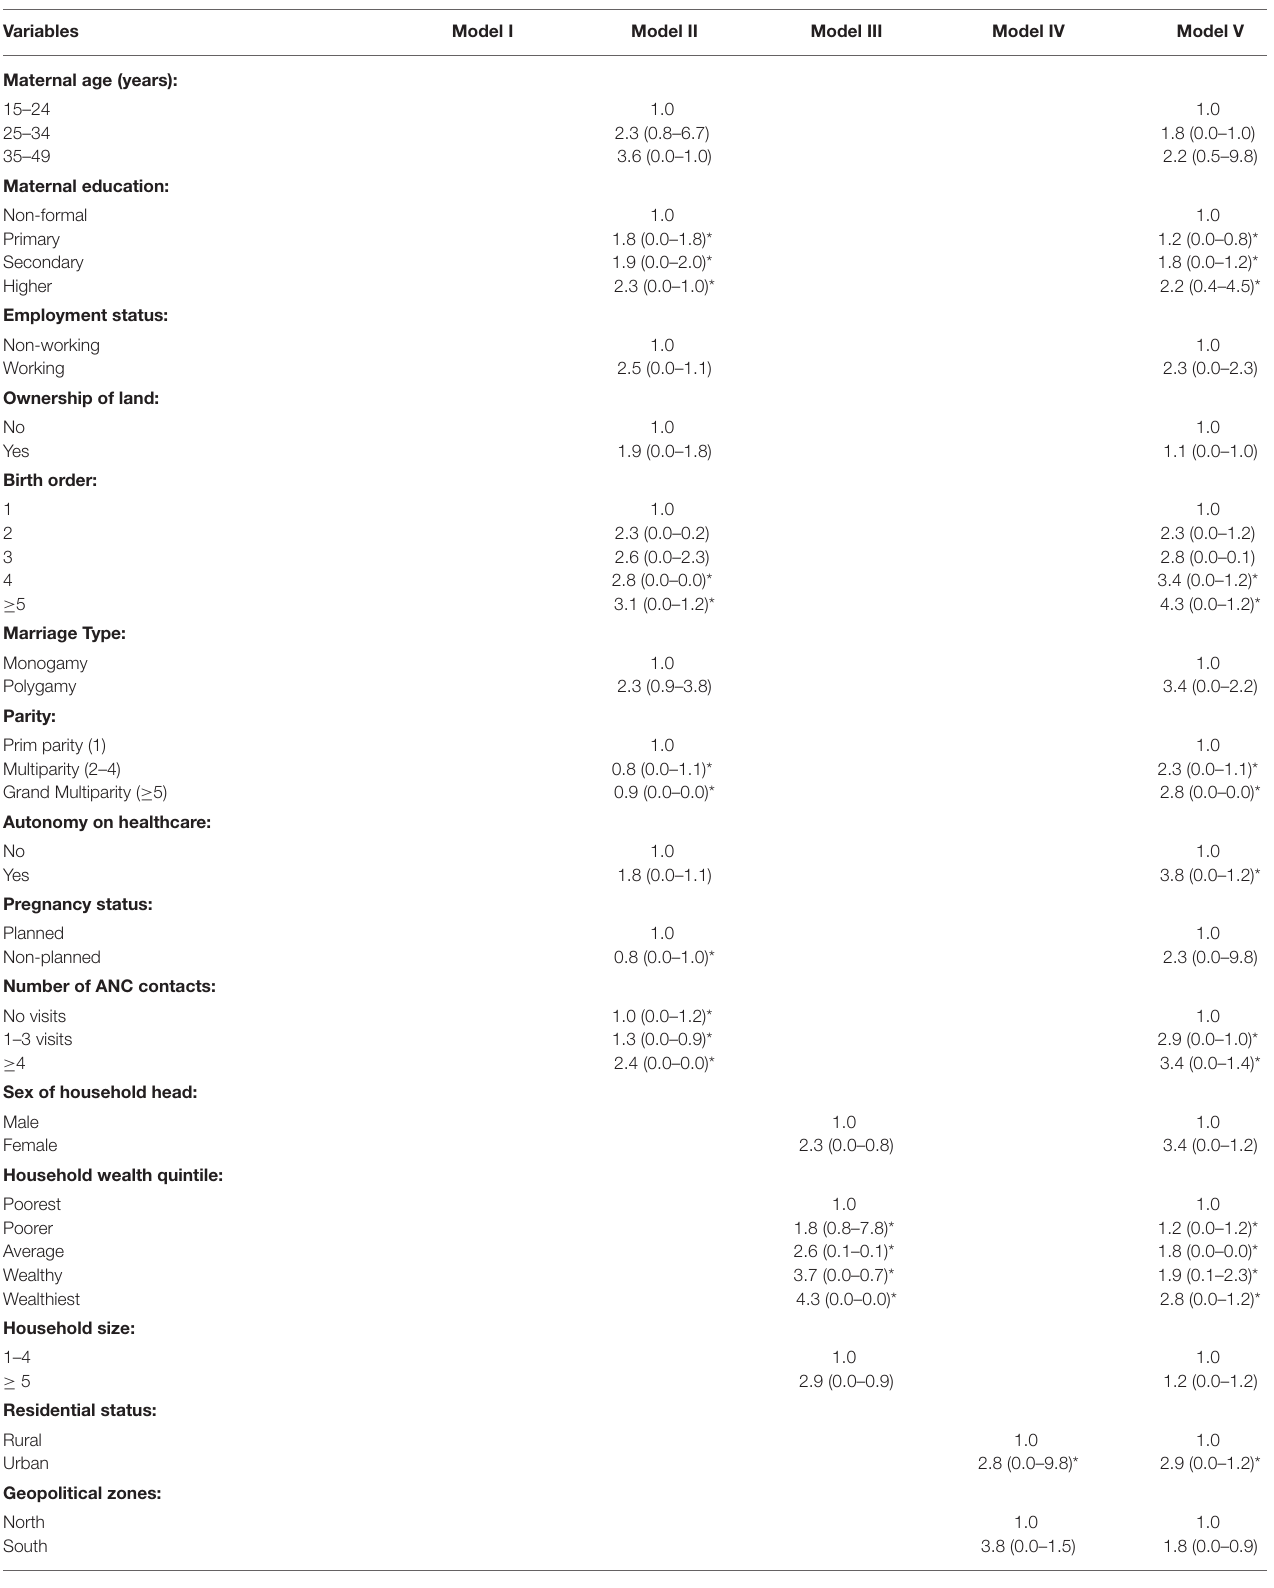
TABLE 3 | Fixed effects of individual, household, and community level factors associated with health facility delivery among women enrolled in health